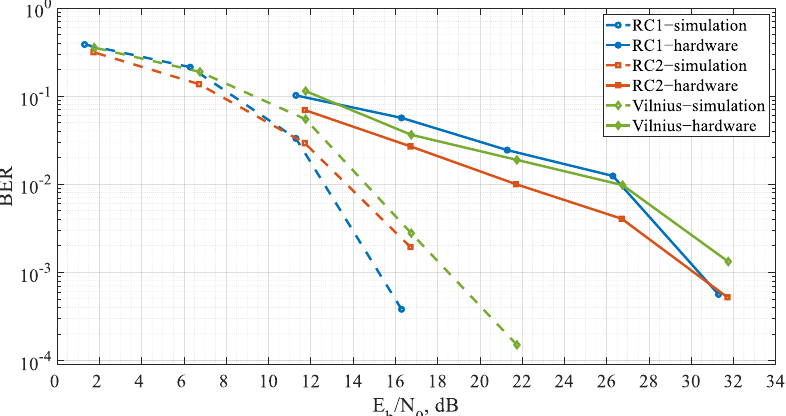
Figure 12. Estimation of communication system’s performance in the AWGN channel using 3 differ-